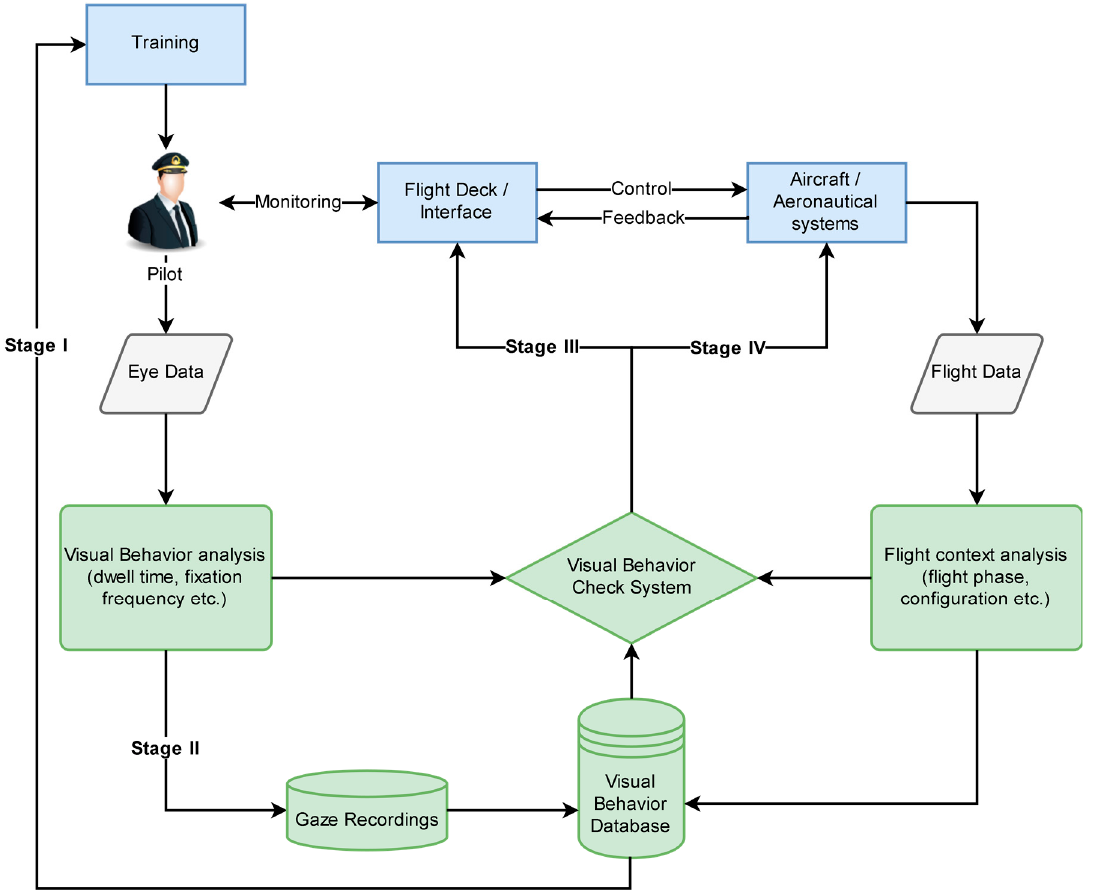
Figure 2. Flowchart of the eye-tracking integration into modern cockpits, including all four stages of the framework. The eye and flight data are recorded (Stage II) and proceed to form a visual behavior database. This database can be used to enhance pilots’ training (Stage I) and to check the consistency of the visual behavior according to the flight context. If an inconsistency is detected, we can adapt flight deck (Stage III) or aircraft systems (Stage IV). Blue rectangles correspond to the existing elements. Green color indicate the elements that are to be integrated.